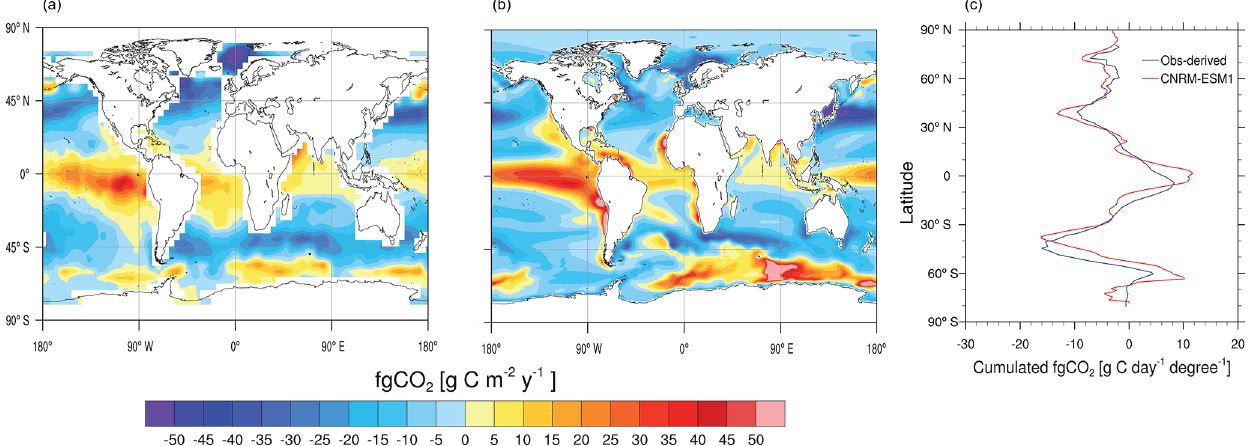
Figure 15. Annual-mean ocean carbon fluxes (fgCO 2 ) as estimated by the Takahashi et al. (2010) database (a) and as simulated by CNRM- ESM1 averaged over 1986–2005 (b) . Panel (c) represents the zonal-cumulated carbon fluxes in function of latitude for both observation-based estimates (in blue) and CNRM-ESM1 (in red). Negative (positive) fluxes indicate an uptake (outgassing) of CO 2